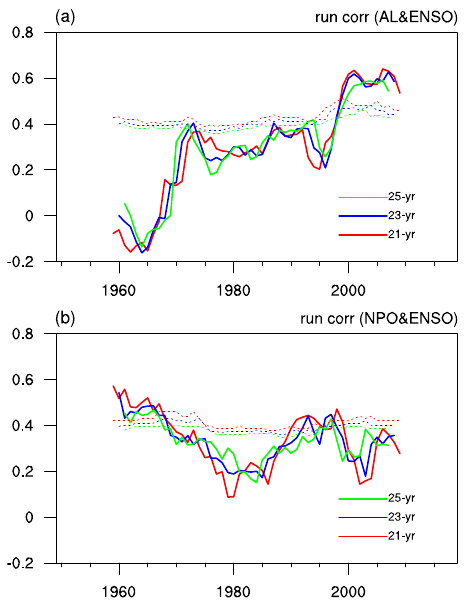
Fig. 1 Correlations of ENSO with preceding AL and NPO. Running correlation coef fi cients of a early-spring (Mar(0)) AL intensity (ALI) index and b winter (D( − 1)JF(0)) NPO index with the following winter (D(0)JF( + 1)) Niño-3.4 SST index with different moving lengths. Time notations “ − 1 ” , “ 0 ” and “ + 1 ” refer to the preceding, current and following years, respectively. Dashed lines indicate the correspond- ing running correlations signi fi cant at the 95% con fi dence level. Effective degree of freedom was considered when estimating signi fi cance level of correlation (see “ Effective degree of freedom ” in “ Methods ” ). Years in a , b are labeled according to the central years of the running